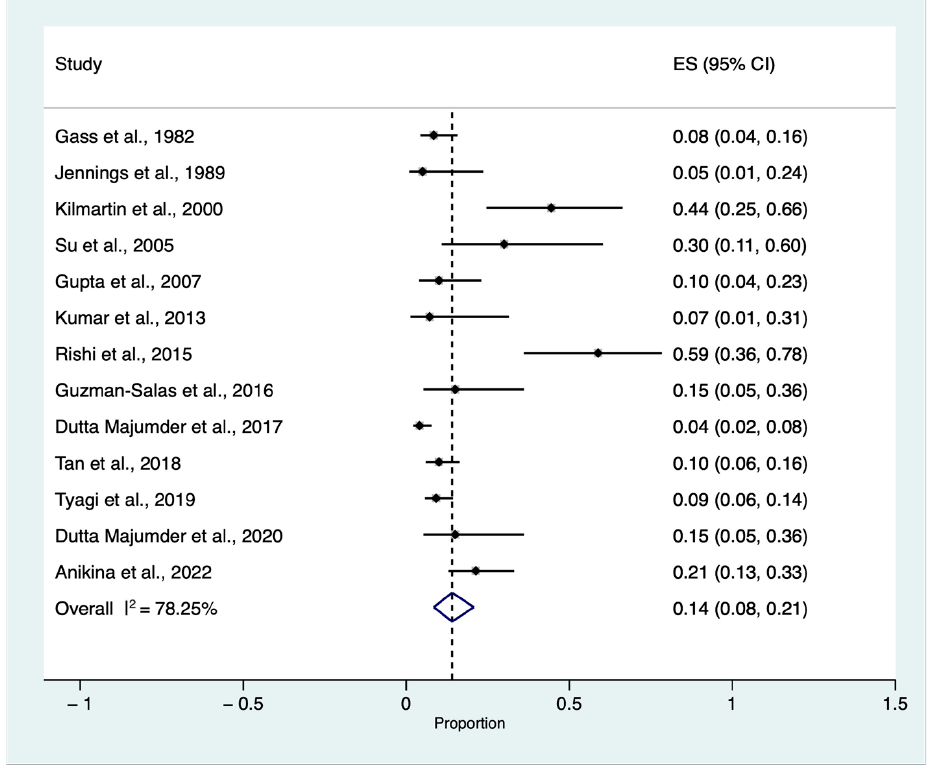
Figure 3. Proportional meta-analysis of cumulative sympathetic ophthalmia (SO) incidence triggered by single or multiple vitreoretinal (VR) surgery procedures in eyes without an antecedent history of trauma and previous ocular surgery, except for previous or concomitant uneventful lens extraction among patients who developed SO regardless of the main trigger [6–10,12–15,17–20]. ES: effect size, CI: con fi dence Interval.